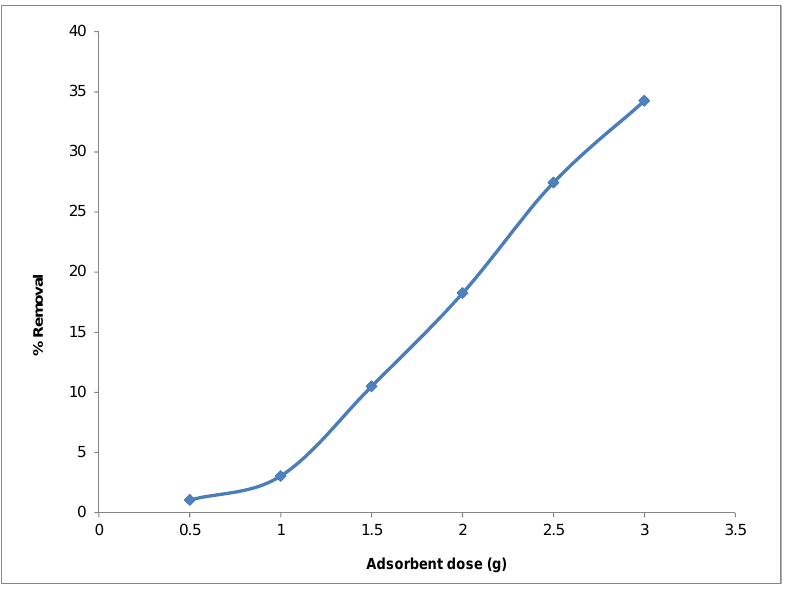
Figure 10. Effect of adsorbent dose on the sorption of Cd(II) ion onto YTBS adsorbent.